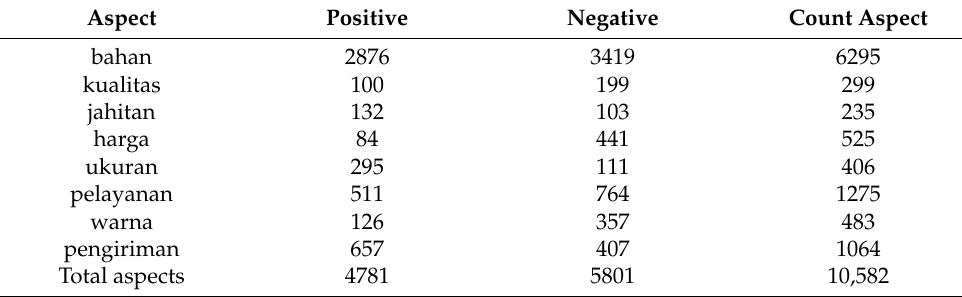
Table 12. The results of automatic labeling using the ABSA model. Aspect Positive Negative Count